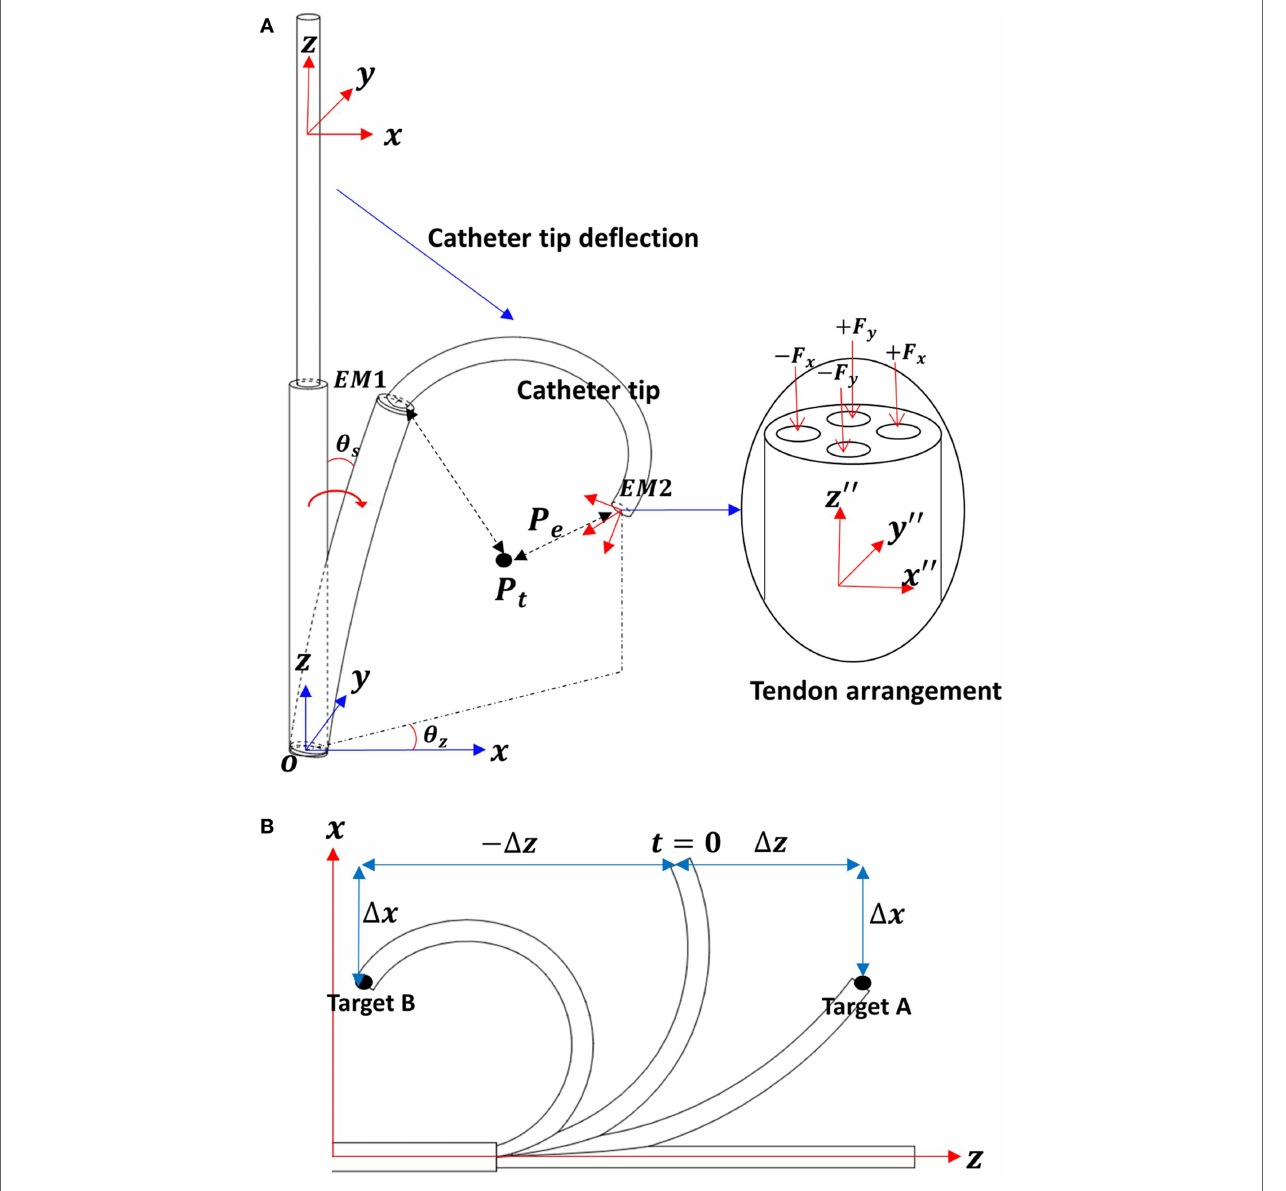
FigUre 7 | (a) Schematic descriptions for the catheter tip deflection. (B) Two-dimensional work space to describe the multiple solutions on x -axis.